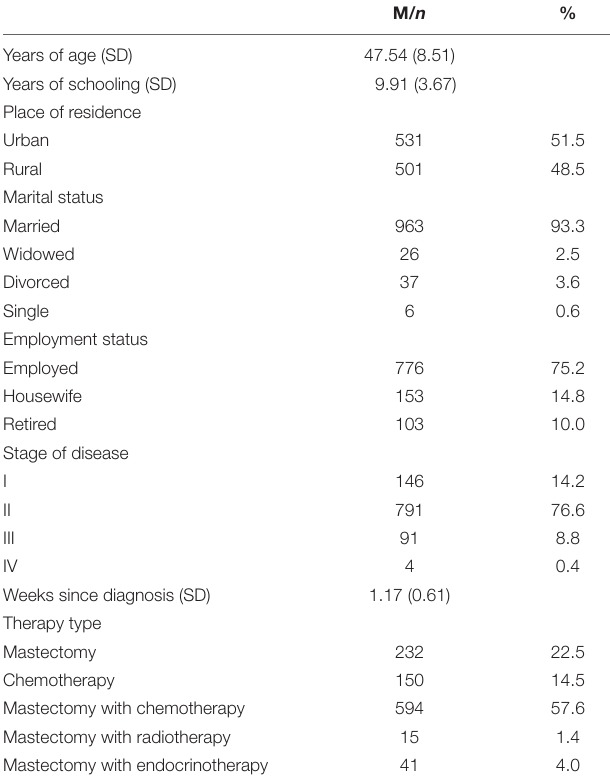
TABLE 1 | Demographic and medical data of the study sample ( n =